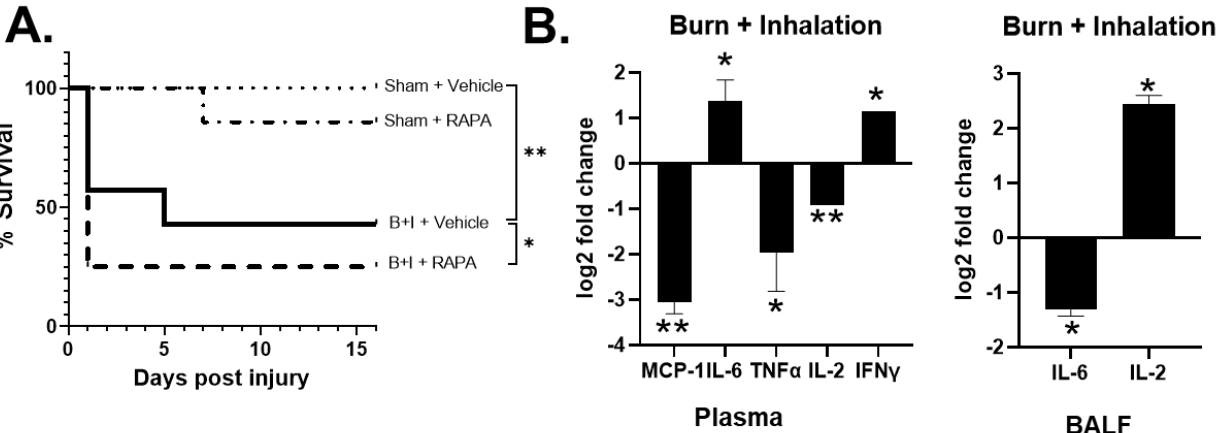
Figure 6. Rapamycin-induced significant mortality after B+I injury with altered local and systemic cytokine profiles. Mice were administered either rapamycin or vehicle for 7 days before receiving either B+I or sham injury (n = 12 per group). ( A ) Survival of mice from injury to 14 days after injury was evaluated. ( B ) Plasma and BALF (n = 6 per group) were harvested 24 h after injury and analyzed using a Bio-Plex mouse cytokine panel 8-plex assay; log2 fold change is shown vs. vehicle-treated injured control mice. In each case, data are presented +/− SEM, with significance represented as * p < 0.05, ** p < 0.01. These data are representative of three independent experiments. Rapamycin-treated B+I-injured mice presented with a significantly altered cytokine profile in the plasma with higher levels of IL-6 and IFN γ , and reduced levels of TNF α